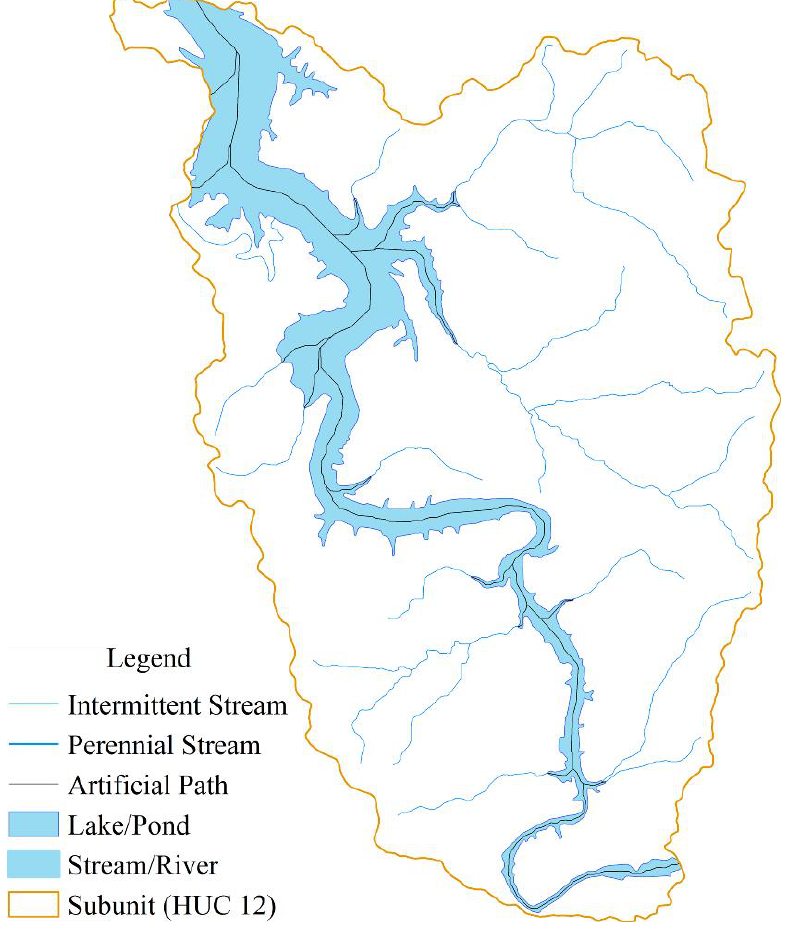
Figure 10. The USGS dataset at 100K